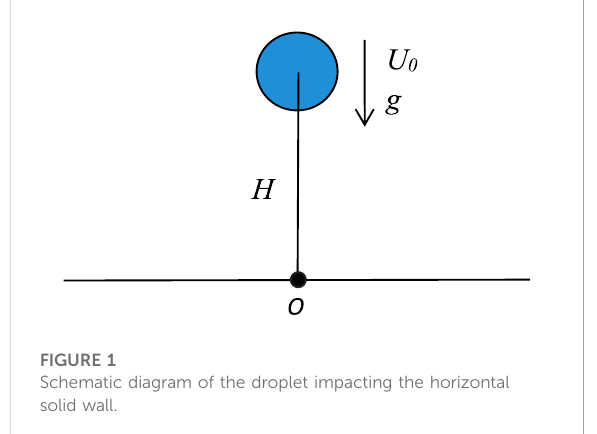
FIGURE 1 Schematic diagram of the droplet impacting the horizontal solid